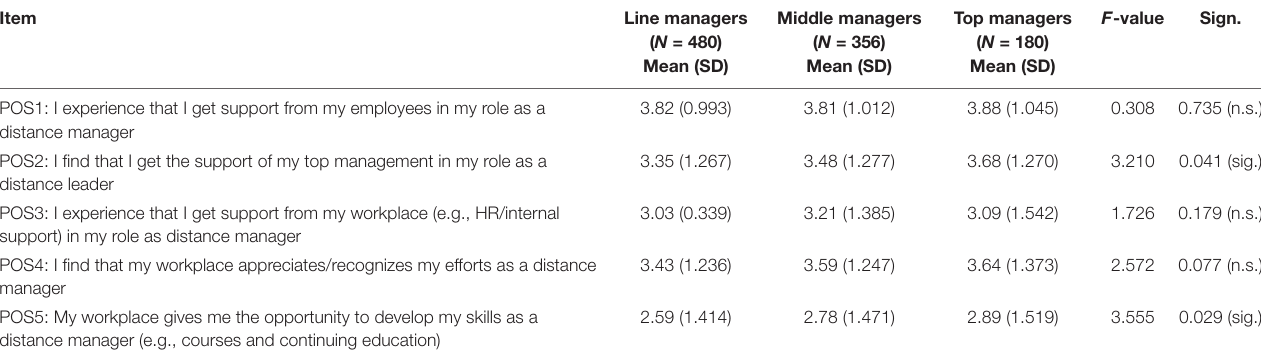
TABLE 4 | ANOVA results for perceived organizational support.